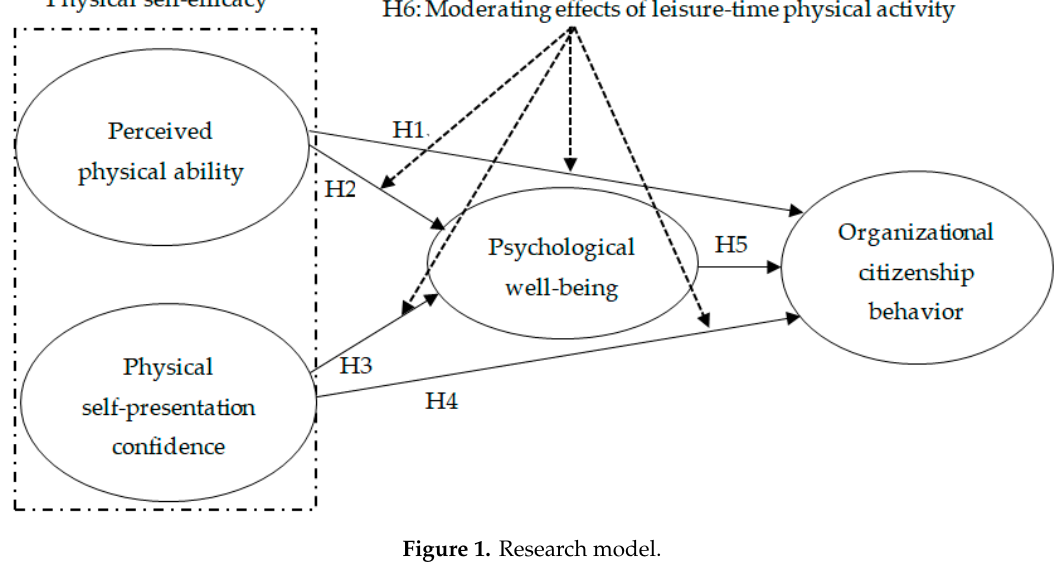
Figure 1. Research Figure 1. Research model .